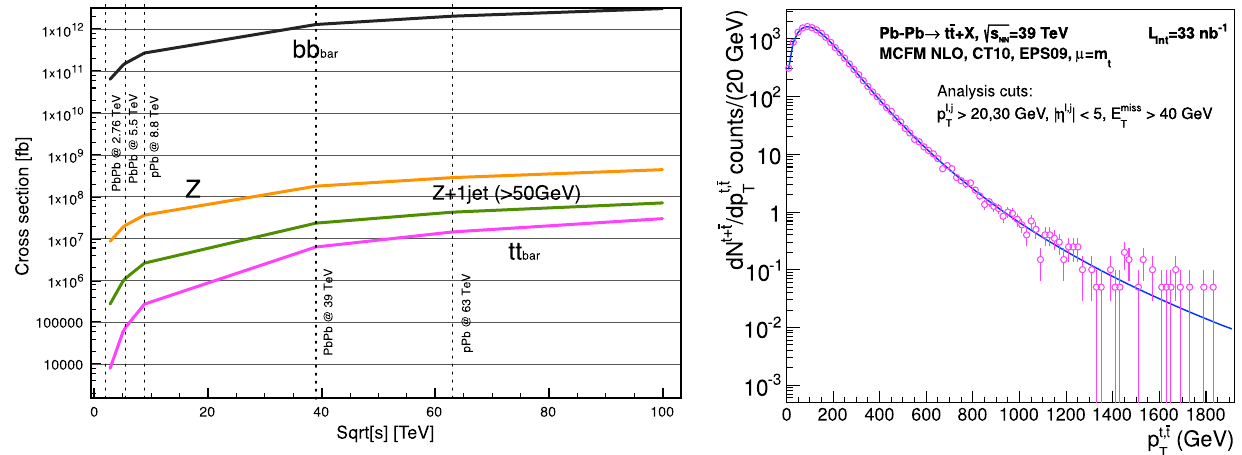
√ Fig. 16.2 Left: s -dependence of the cross sections for hard processes of interest for a heavy-ion programme, calculated with MCFM [404] at the highest available order. Right: expected top-quark p T distribution